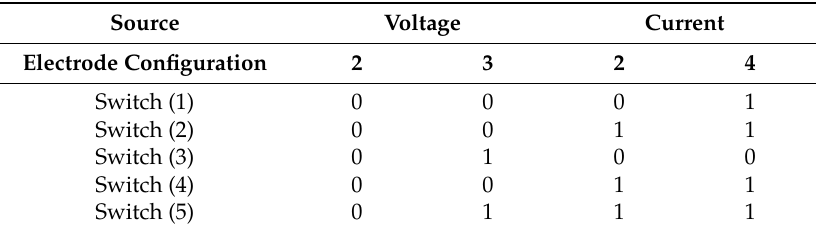
Table 3. Truth table of the switching protocol for switches (1) to (5) of Figure 5. Electrode configurations allow for two, three and four electrode impedance measurements using current or voltage excitation,